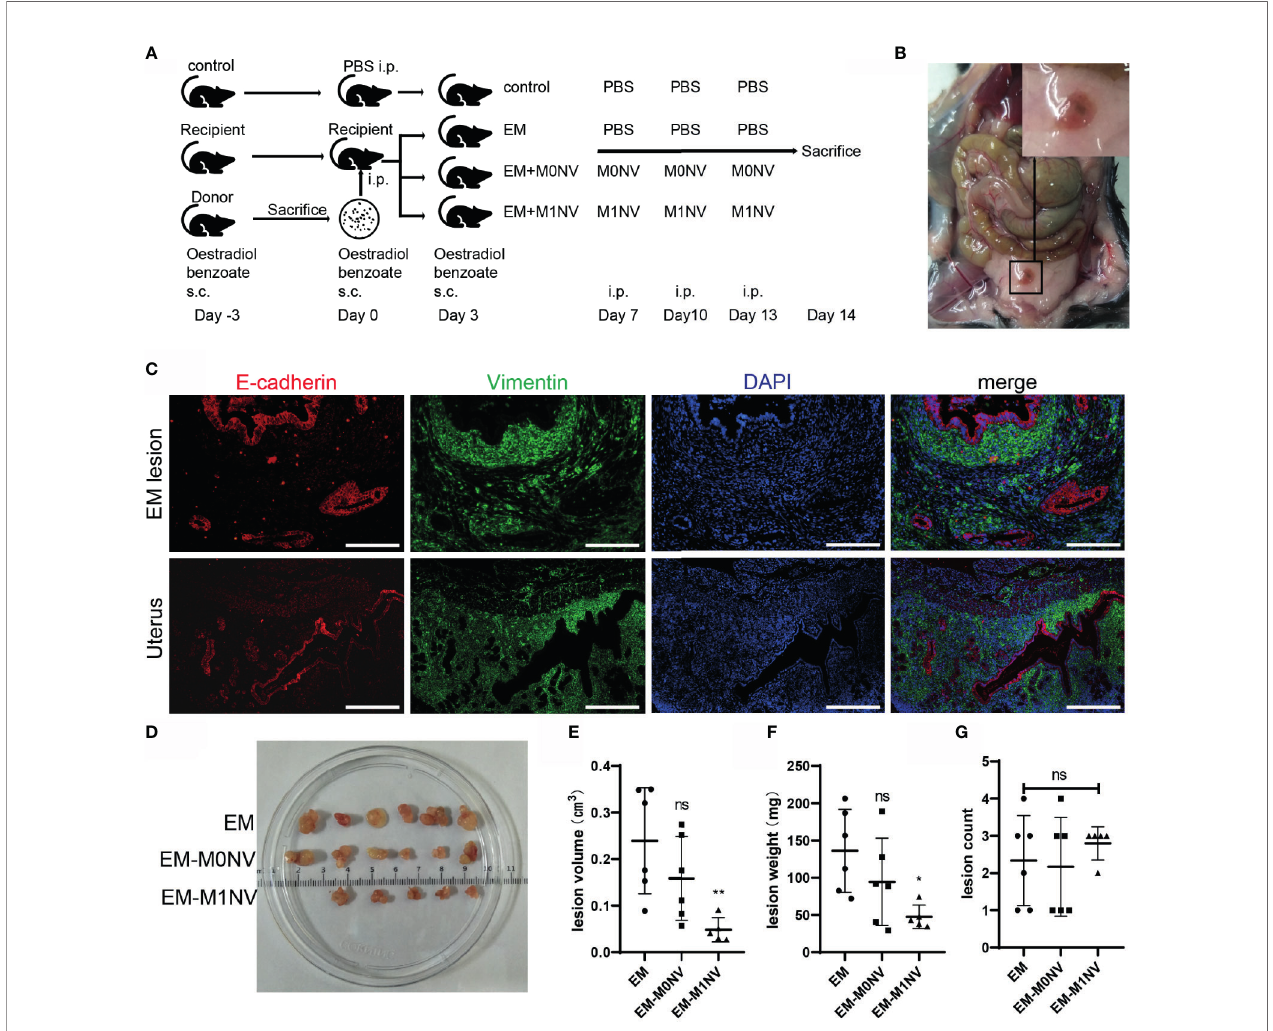
FIGURE 5 | M1NVs inhibited the development of endometriosis in a murine model. (A) Flow diagram of the experiment in vivo . (B) Typical ectopic endometrial lesion could be found in the peritoneal cavity of the mouse model 14 days after uterus fragment injection. (C) Immuno fl uorescence staining showed the ectopic lesion had typical endometrial glands (E-cadherin positive, red) and stroma (Vimentin positive, green) (Scale bar =100 m m). (D) Ectopic lesions in different groups. (E, F) Treatment of M1NVs signi fi cantly reduced the volume and weight of lesions. (ns: no signi fi cance when compared with EM. *P<0.05, **P<0.01 when compared with EM). (G) The count of lesions was not different among